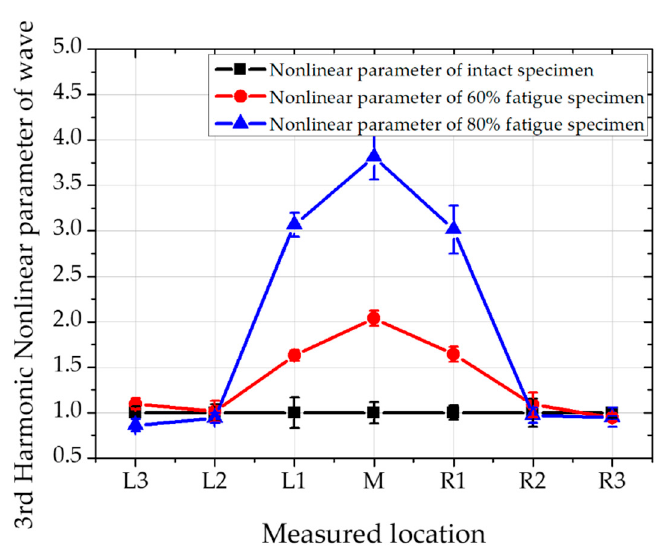
Figure 9. Third harmonic wave for measuring nonlinear parameter at various positions. Table 4. Comparison on second and third harmonic nonlinear parameter.